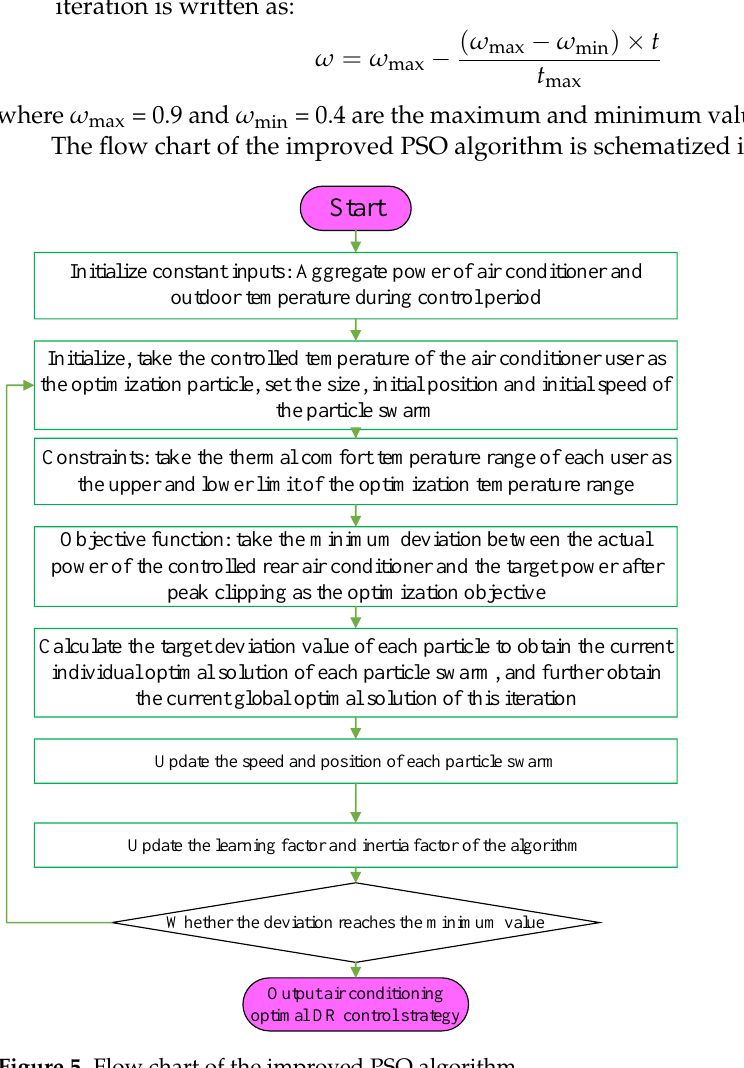
Table 2. Load parameter range of fixed-frequency air-conditioning.